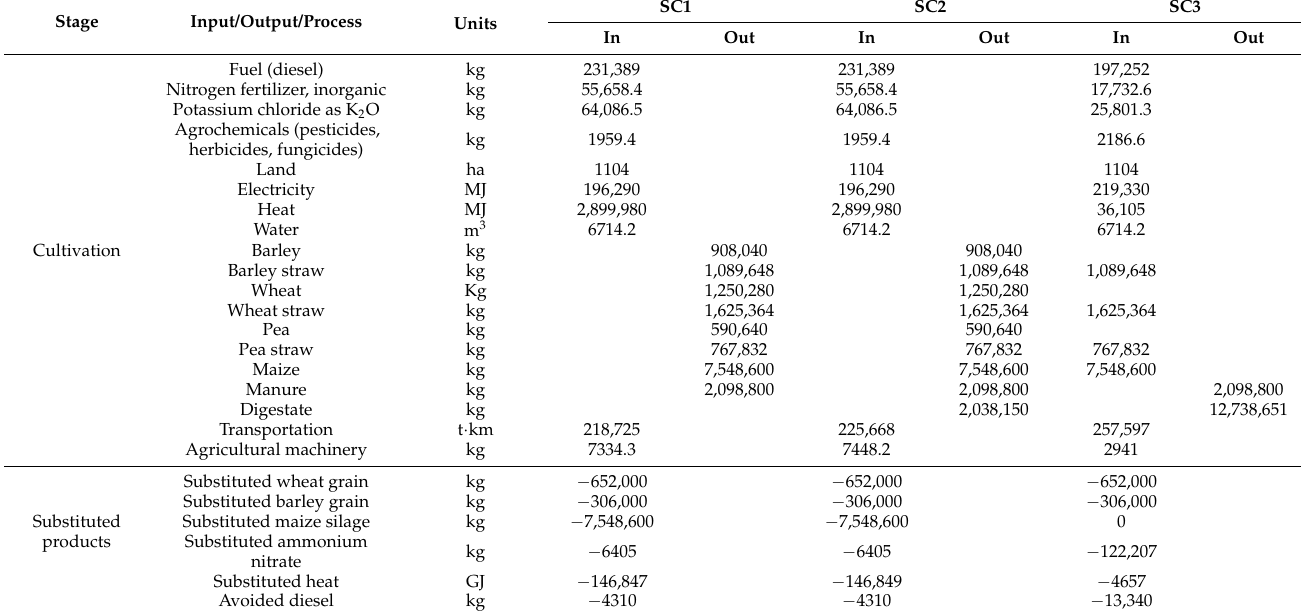
Table 5. Inventory of inputs and outputs for a reference flow of 1000 pig farm of three scenarios.